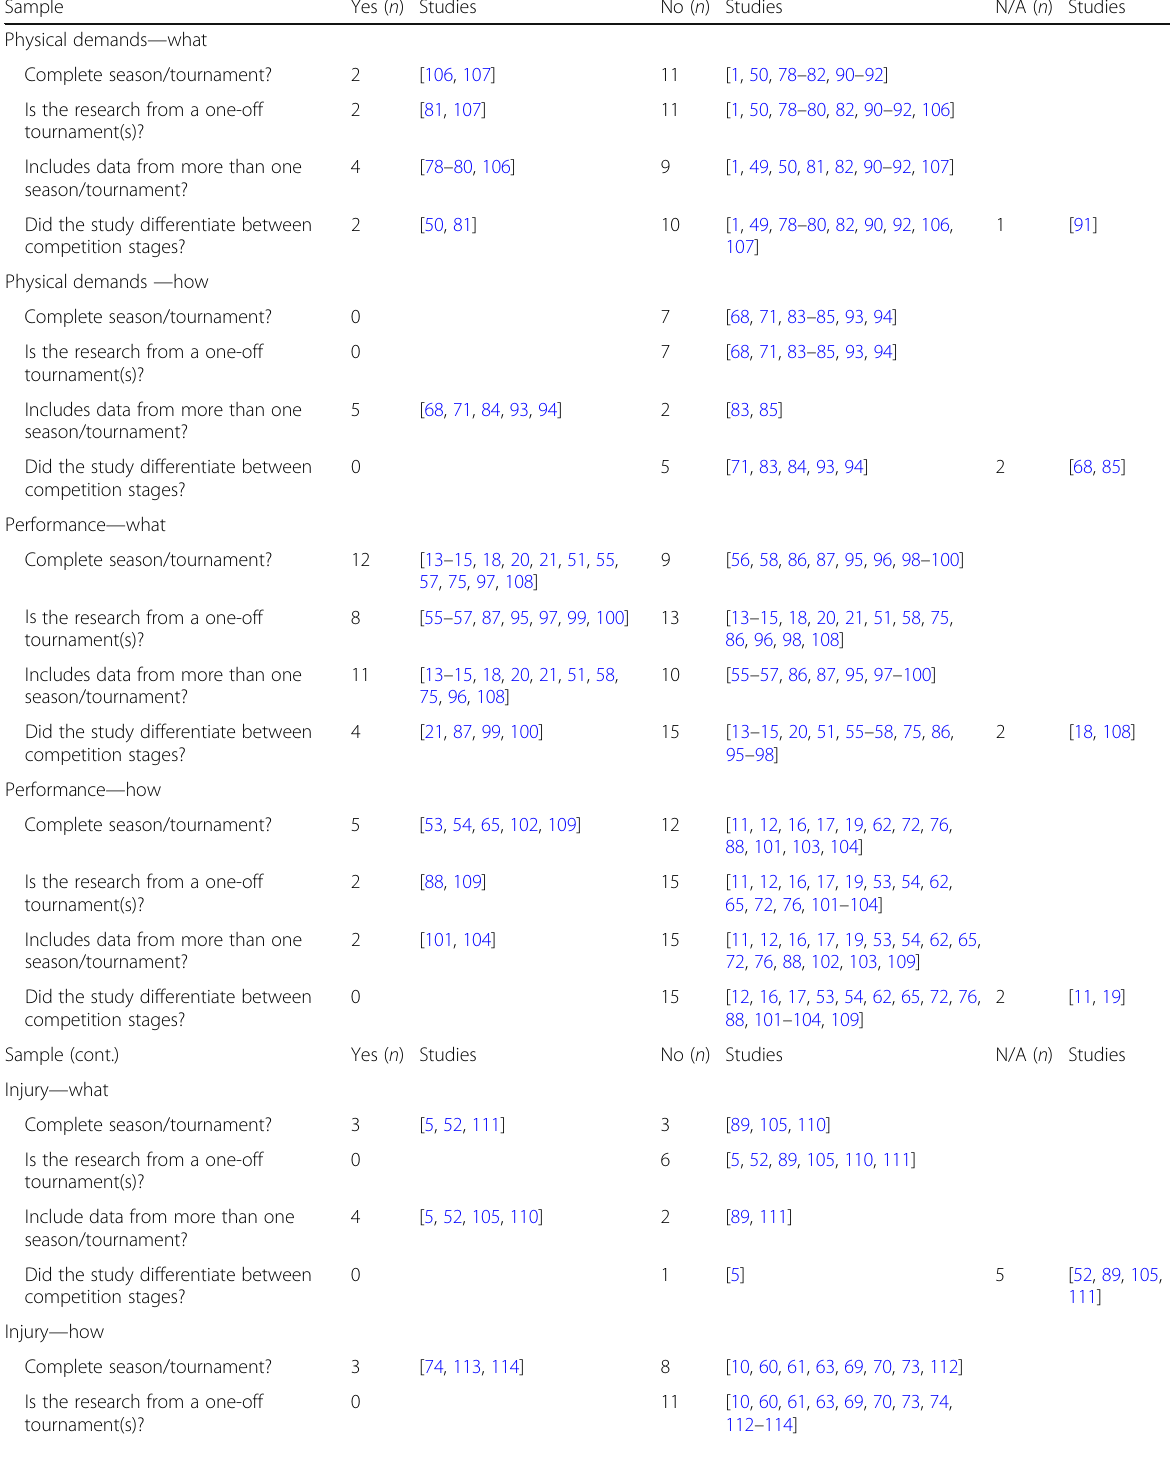
Table 3 A summary of the types of samples selected